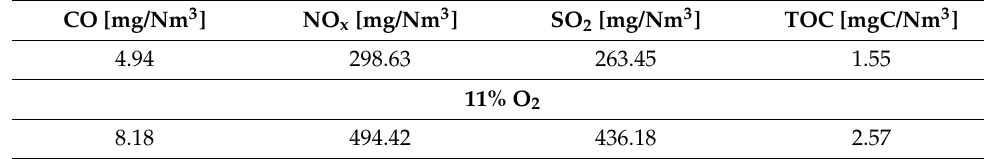
Table 6. Conversion into mg/Nm 3 and related to 11% of O 2 .